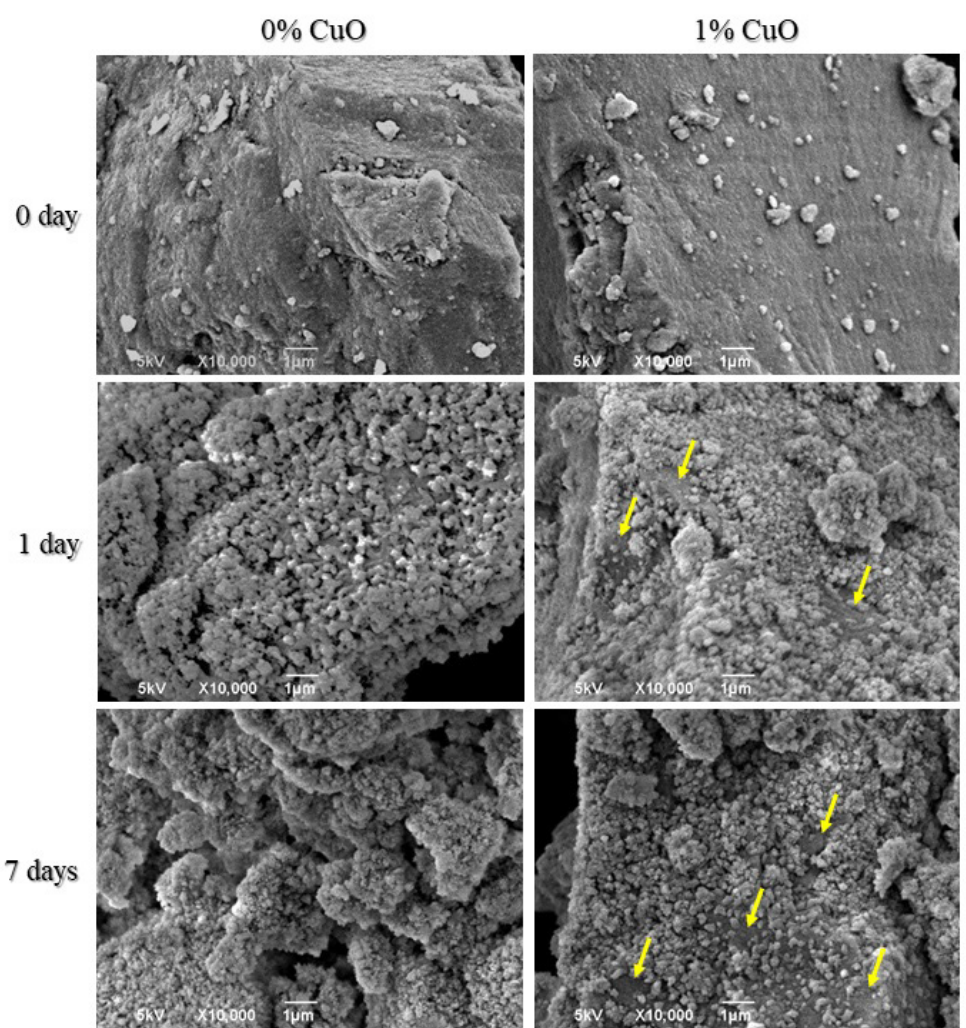
Figure 3. SEM images of the bioactive glass samples before (0 day or before the SBF assay) and after 1 and 7 days of immersion in SBF. Low-order hydroxyapatite nanocrystals coating the surfaces are observed after immersion in SBF. Yellow arrows show uncoated regions on the CuO-containing